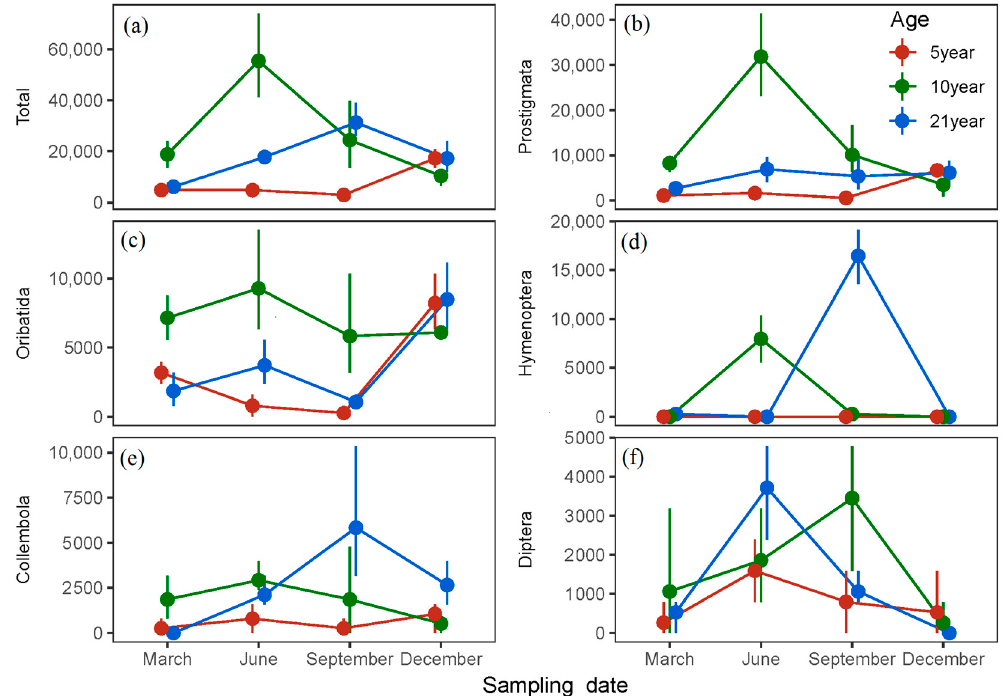
Figure 1. The effects of stand age and sampling date on the abundance (ind. m − 2 ) of soil arthropods. Filled circles are bootstrapped means with 95% bootstrapped confidence intervals (error bars). Difference is statistically significant at α = 0.05 when 95% bootstrapped confidence intervals do not overlap other means. ( a – f ) stands for the abundance of Total, Prostigmata, Oribatida, Hymeoptera, Collembola and Diptera, respectively.